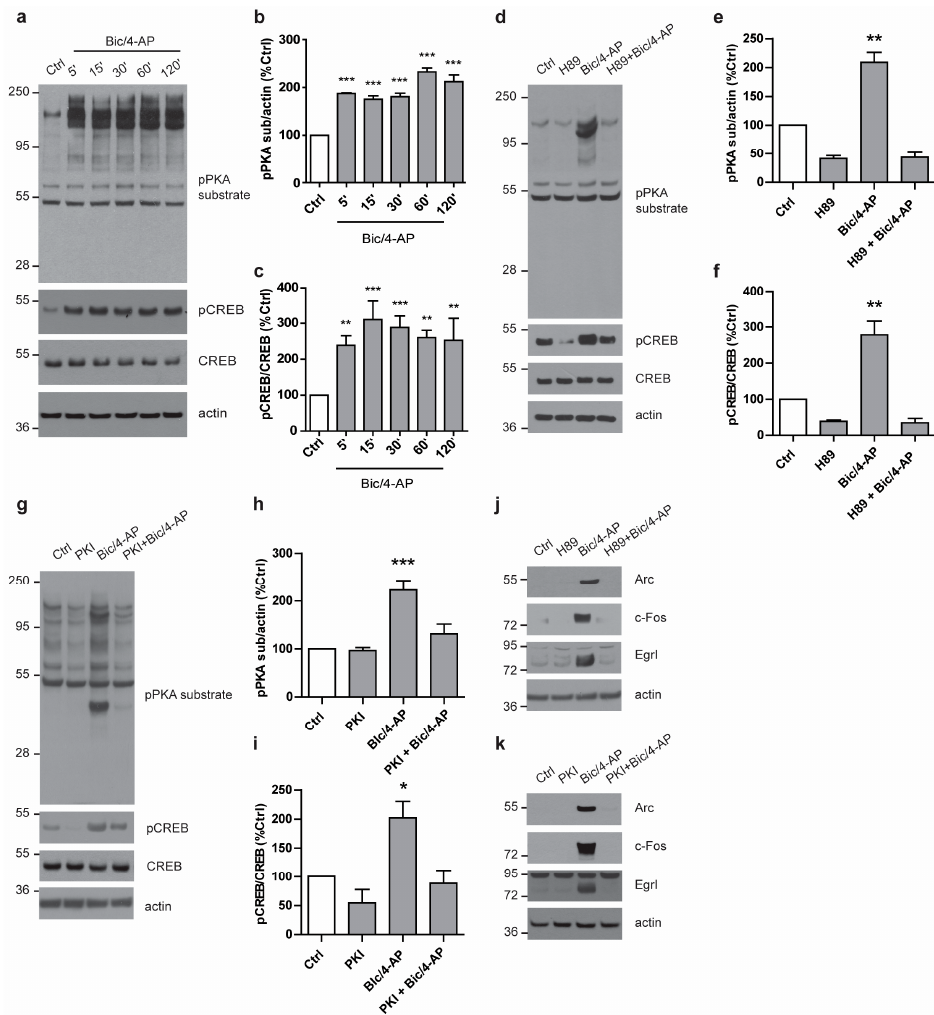
Figure 3. The cAMP-dependent protein kinase (PKA) pathway is rapidly activated following synaptic activation and is required for the expression of IEGs. (3 ′ ,5 ′ -cyclic AMP = cAMP) ( a ) Primary neurons activation and is required for the expression of IEGs. (3 (cid:48) ,5 (cid:48) -cyclic AMP = cAMP) ( a ) Primary neurons at at 15 DIV treated with Bic/4-AP (50µM/2.5mM) for the indicated times were subjected to 15 DIV treated with Bic/4-AP (50 µ M/2.5mM) for the indicated times were subjected to immunoblotting with anti- phospho-PKA substrate (pPKA sub), phospho-CREB (pCREB), total CREB, and actin antibodies. (cAMP response element binding = CREB) ( b, c ) Quantification of WB as in (a) showing the ratios pPKA sub/actin ( b ) and pCREB/CREB ( c ) expressed as a percentage of control